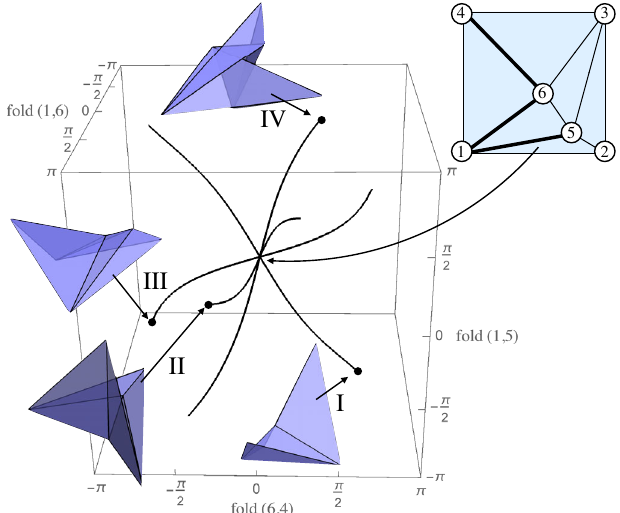
FIG. 1. A neighborhood of the unfolded state in the configu- ration space of a two-vertex origami structure (inset) projected onto the fold angles of three folds (thick lines). This was computed by solving numerically the length constraint equations [Eq. (1)]. Locally, there are four branches, labeled I – IV, each a one-dimensional configuration space, all intersecting at a single point: the flat, unfolded configuration. Movies 1 – 4 in Supple- mental Material [23] show animations of these branches. We did not attempt to compute the global structure of the configuration space, e.g., how the branches join.